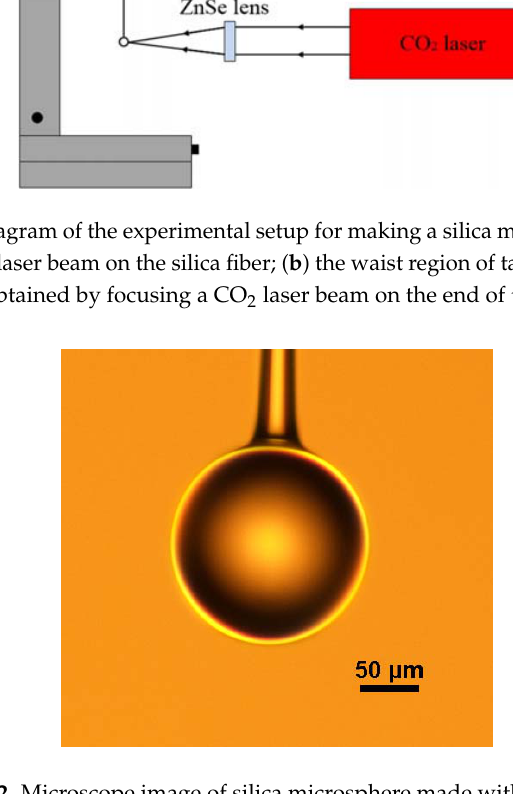
Figure 3. Schematic diagram of the experimental setup used for making a lead silicate microsphere. ( a ) Cross ‐ section of lead silicate fiber; ( b ) a fiber is tapered by using a microheater; ( c ) the uniform waist of the tapered fiber is cleaved; ( d ) a lead silicate microsphere is formed. Reprinted/Adapted with permission from [64].